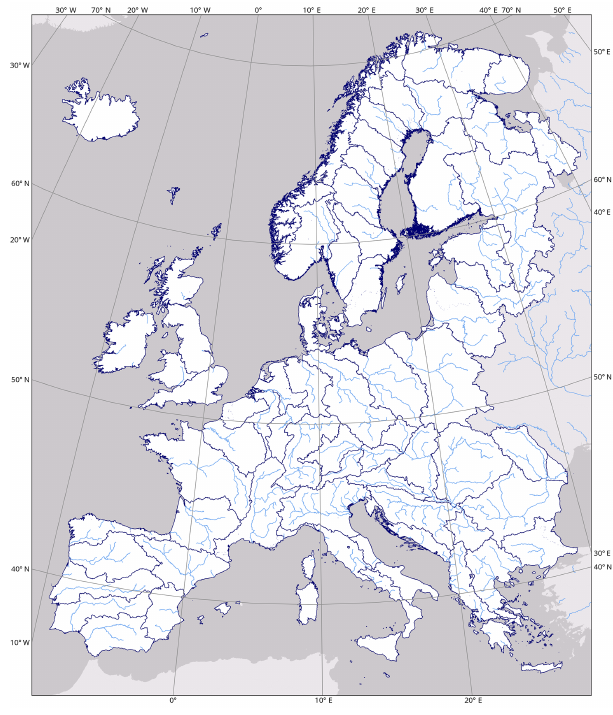
Figure 2. Map of the 74 European regions (dark blue outlines) se- lected for the analysis of the CM-SSF and the